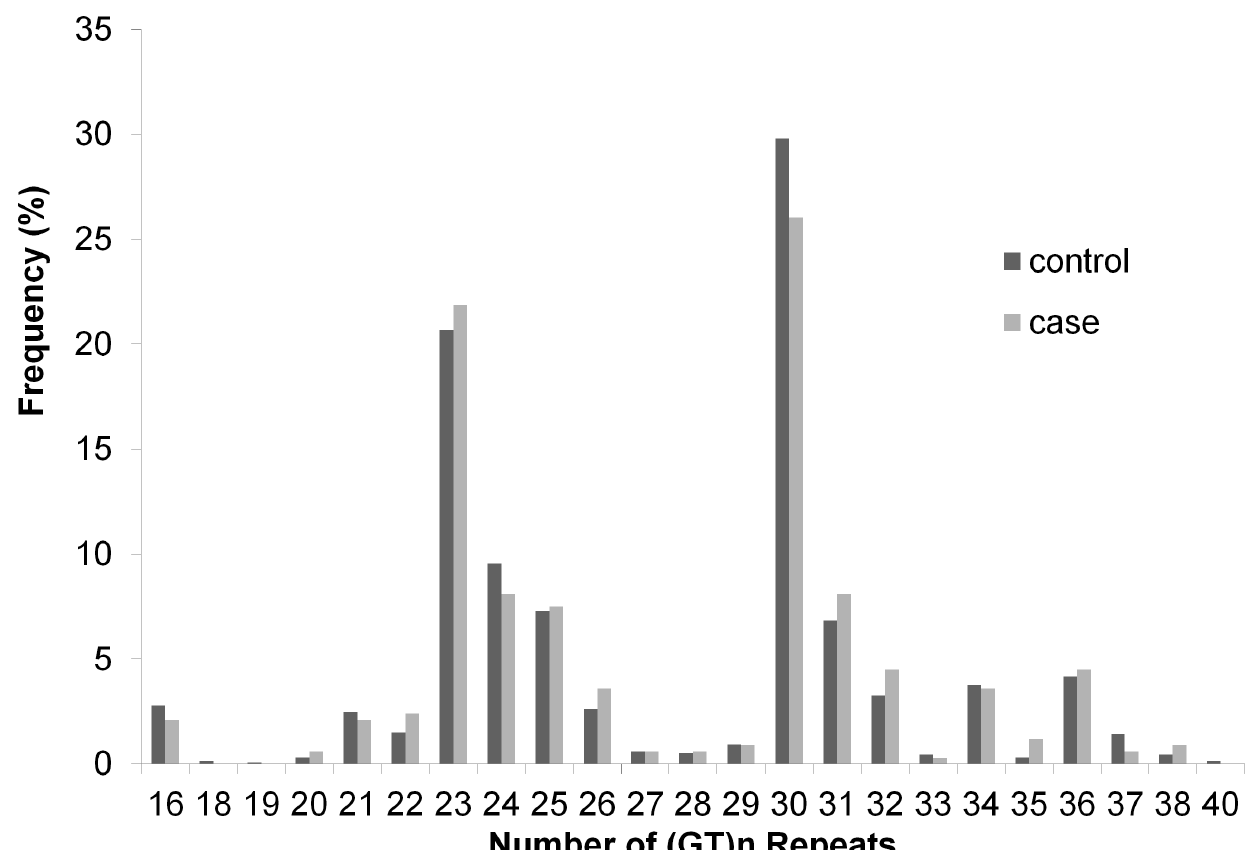
Figure 1. Distribution of (GT) n repeat of HMOX1 .